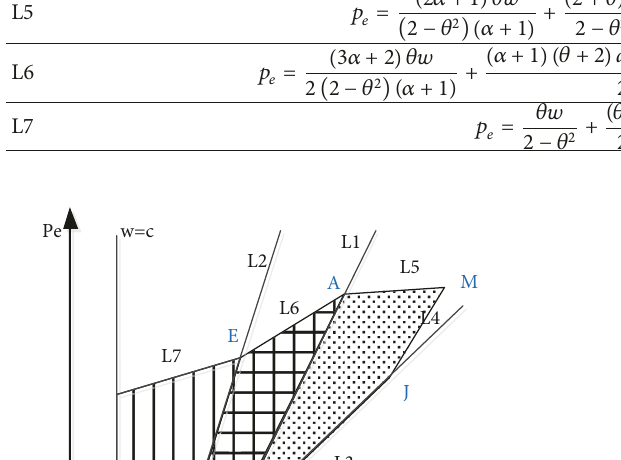
𝑖 . ( 𝑤 𝑓∗ , 𝑝 𝑓∗ 𝑖,𝑗 𝑒,𝑖,𝑗 ) denotes the maximum point on boundary region 𝑖